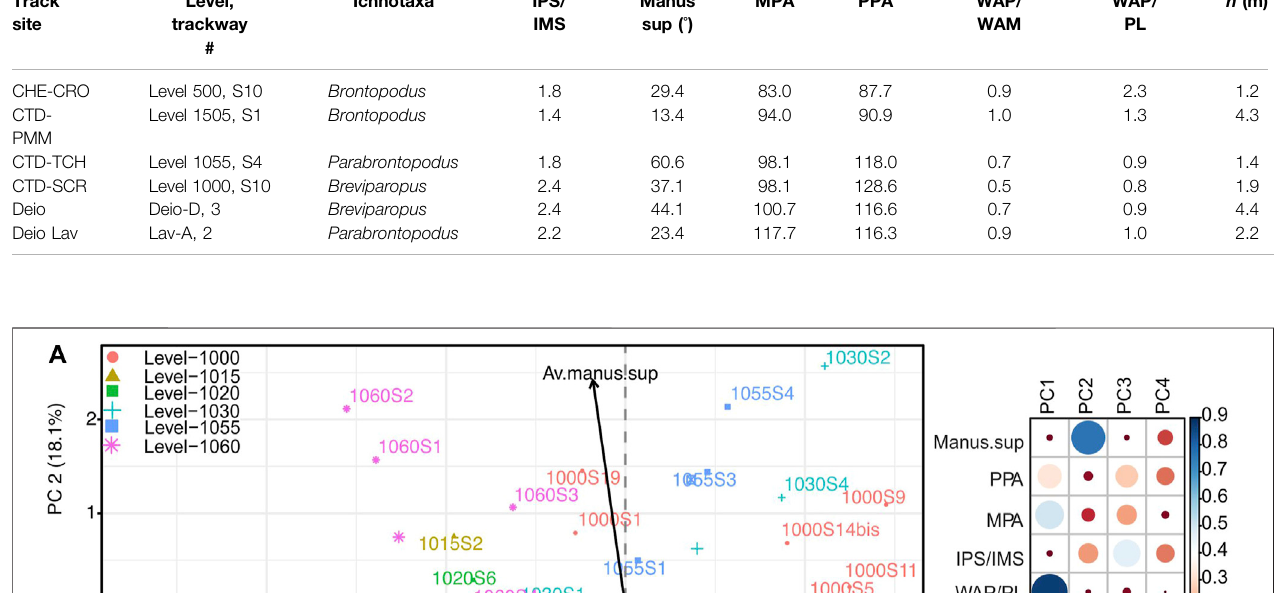
Frontiers in Earth Science |